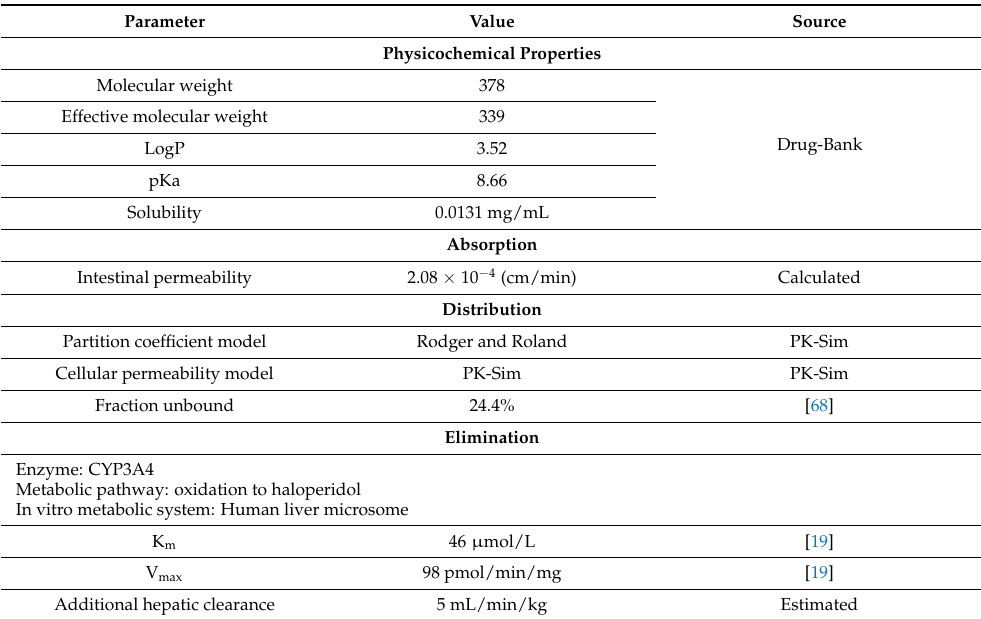
Table 3. Input data for the PBPK model of reduced haloperidol